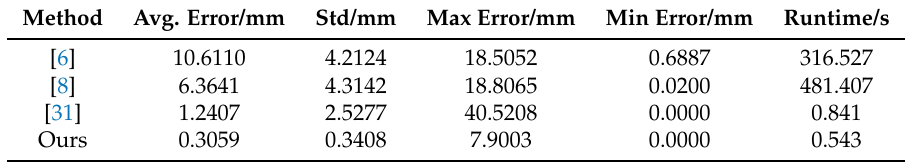
Table 2. Results comparison on gauge block measurements with different depth